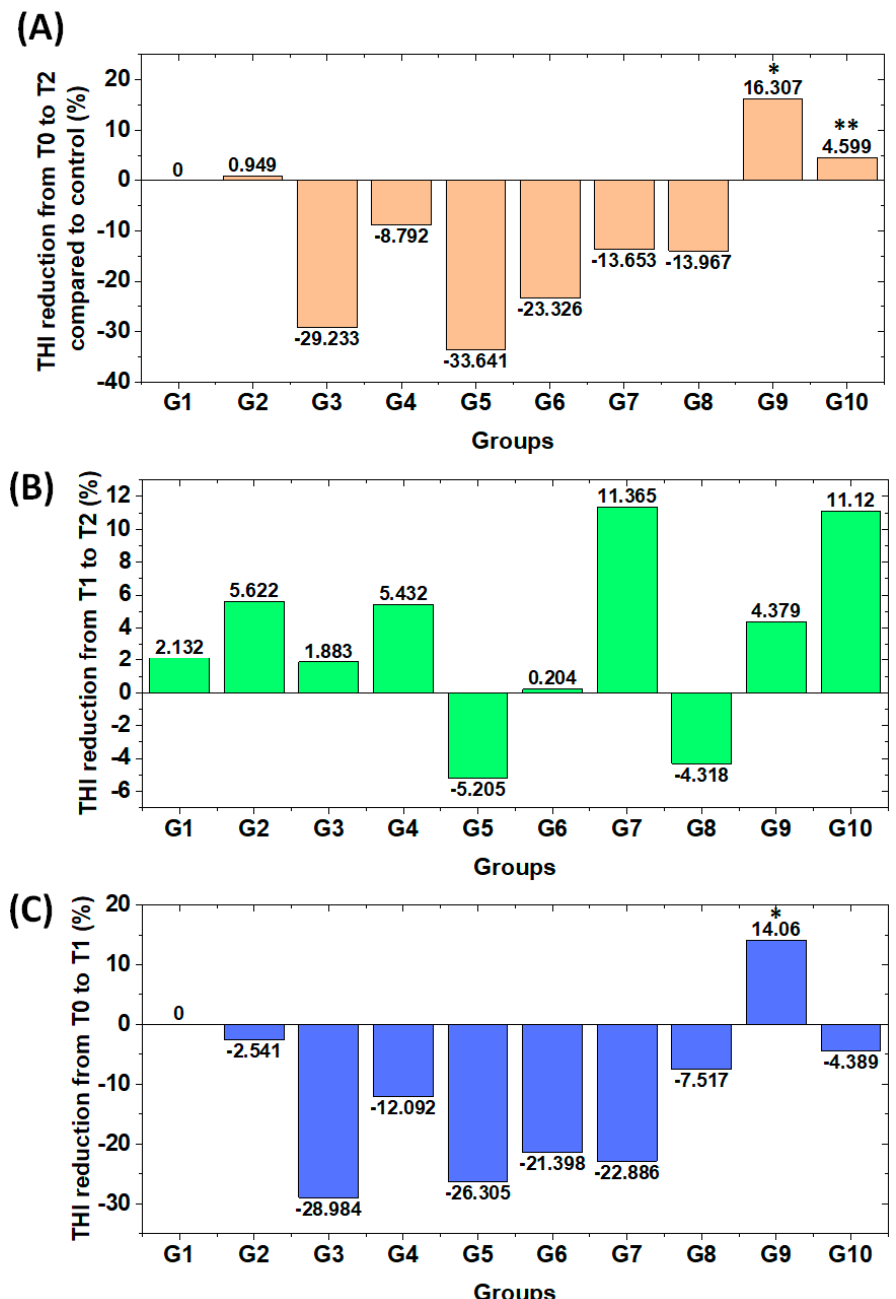
Figure 4. Comparison between study groups showing the evolution of different interventions to treat tinnitus. This comparison was made in relation to the ( A ) TO 15 , i.e., average normalized THI score reduction 15 days after complete treatment suspension (period T 2) and excluding the placebo effect (subtraction of the 40.1% THI score reduction induced in patients of G1 at T 2); ( B ) LTE 15 , i.e., average THI score reduction 15 days after the treatment has been completely suspended (i.e., the difference between the normalized THI score s immediately after 8 treatment sessions (period T 1) and normalized THI score s 15 days of no treatment of any sort (period T 2)) and ( C ) TO 0 , i.e., average normalized THI score reduction immediately after the 8 treatment sessions (period T 1) excluding the placebo effect (subtraction of the 38.0% THI score reduction induced in patients of G1 at T 1). Statistically significant differences were observed between G5 × G9 ( p < 0.05; indicated by * in Figure 4A,C) and G6 × G10 ( p < 0.05; indicated by ** in Figure